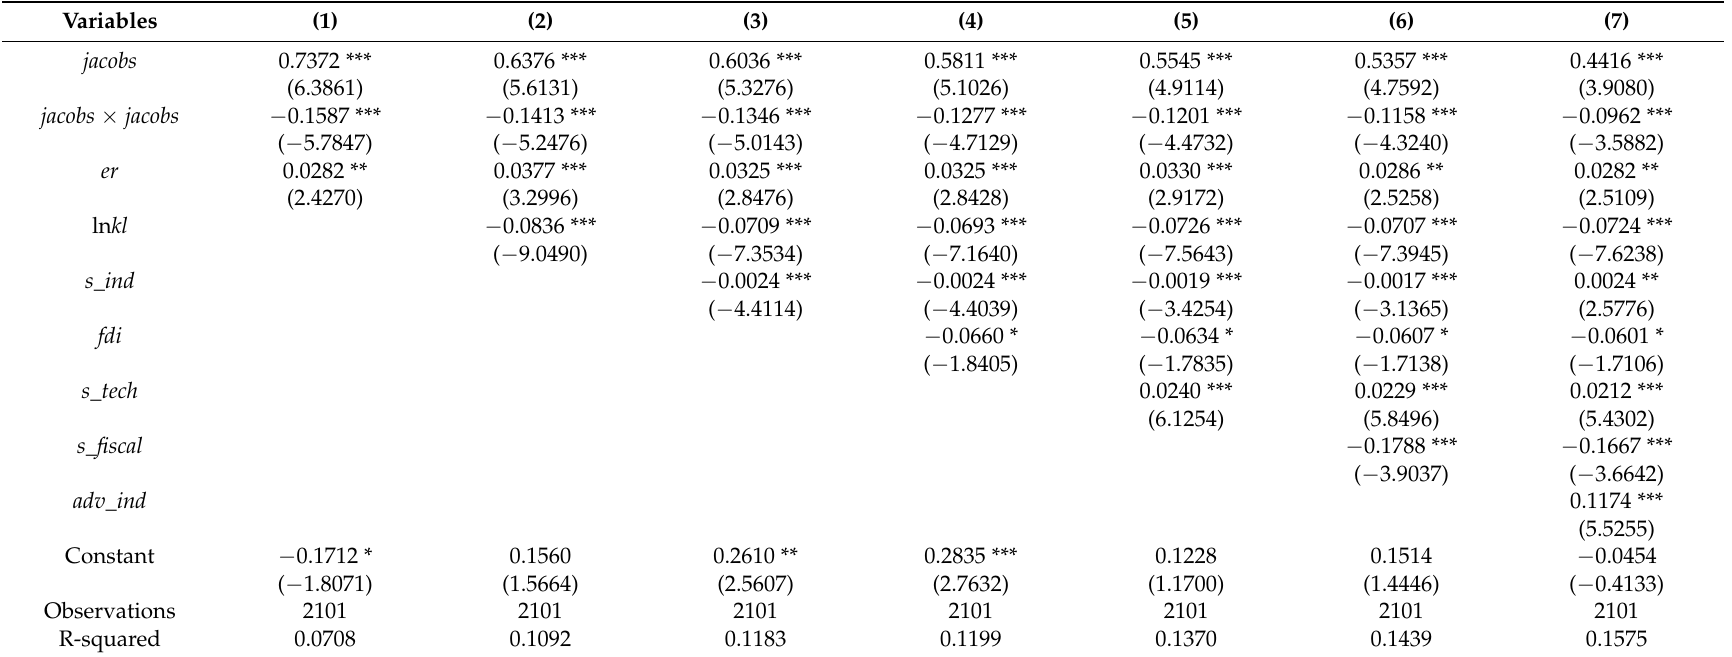
Table 4. Estimation results of Jacobs externality and urban